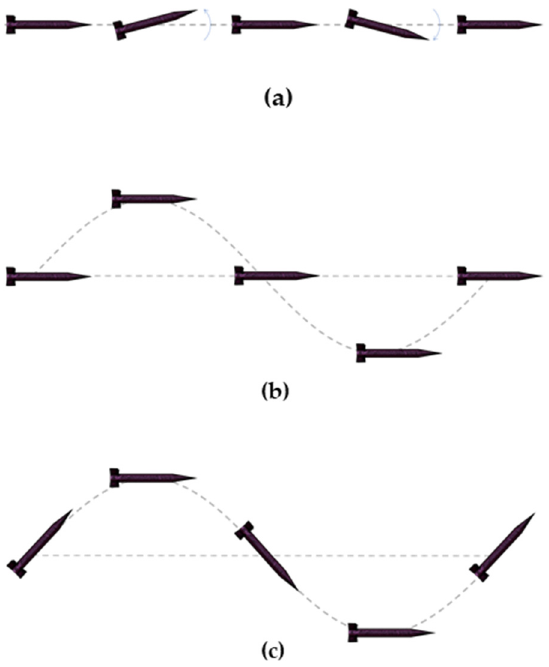
Figure 1. Simple harmonic oscillation methods: ( a ) pitching mode; ( b ) plunging mode; ( c ) flapping mode. Reproduced with permission from Baigang Mi et al, Review of Numerical Simulations on Aircraft Dynamic Stability Derivatives; published by Springer Nature, 2019 [25].